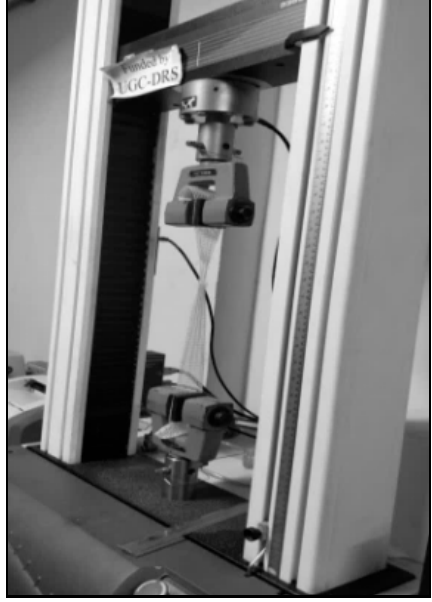
Figure 3. Tensile testing of warp knitted samples.